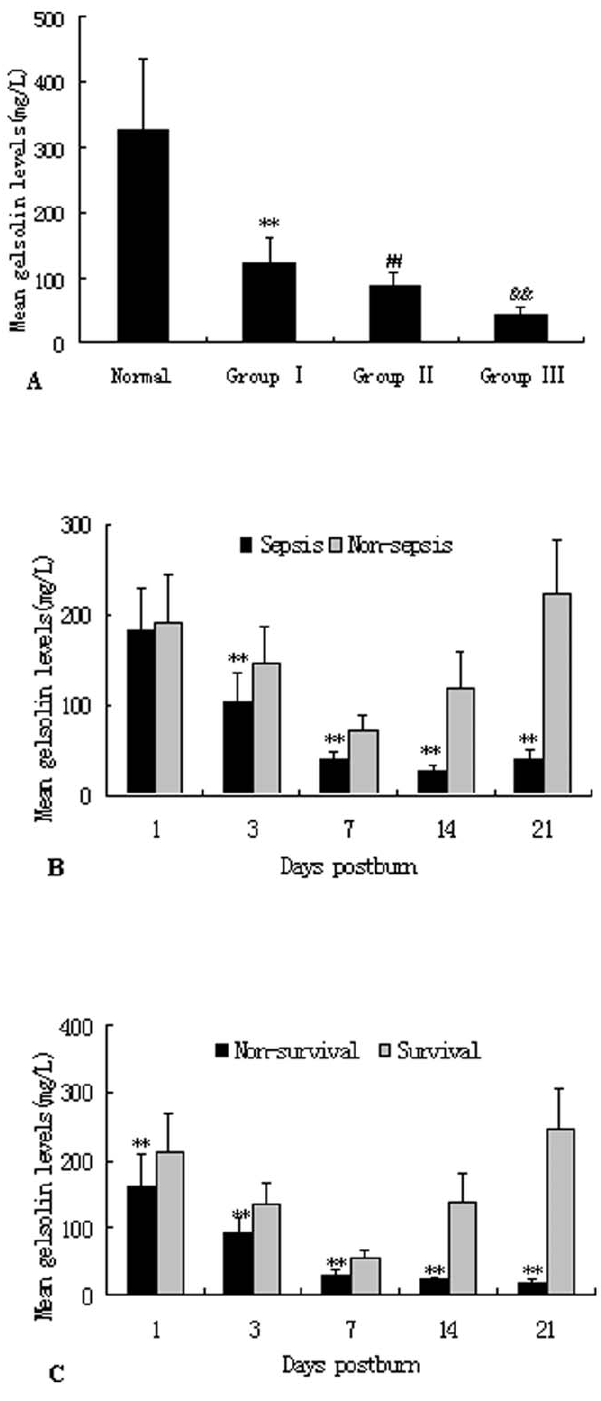
Figure 2. Comparison of pGSN levels in burned patients with or without MODS. Depressed pGSN levels (Fig. 2A) in burned patients were detected in comparison to normal controls, and there were obvious differences among patients with different extent of burn injury. pGSN levels (Fig. 2B) were much lower in patients with MODS than those without MODS on PBD 3–21. Among patients with MODS, pGSN levels in the survivors were obviously lower than those with non- survivors on PBD 1–21 (Fig. 2C). **P , 0.01, Group I vs. normal group, or MODS group vs. non-MODS group, or non-survivors group vs. survivors group; ## P , 0.01, Group II vs. Group I; {{ P , 0.01, Group III vs. Group II.